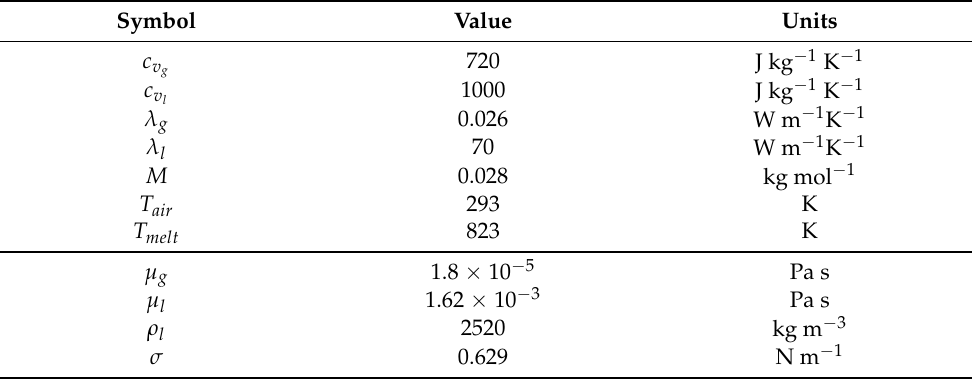
Table 1. Non-geometrical model parameters. The parameters for gas are those for air; those for metal are for the alloy AlSi 9 Cu 3